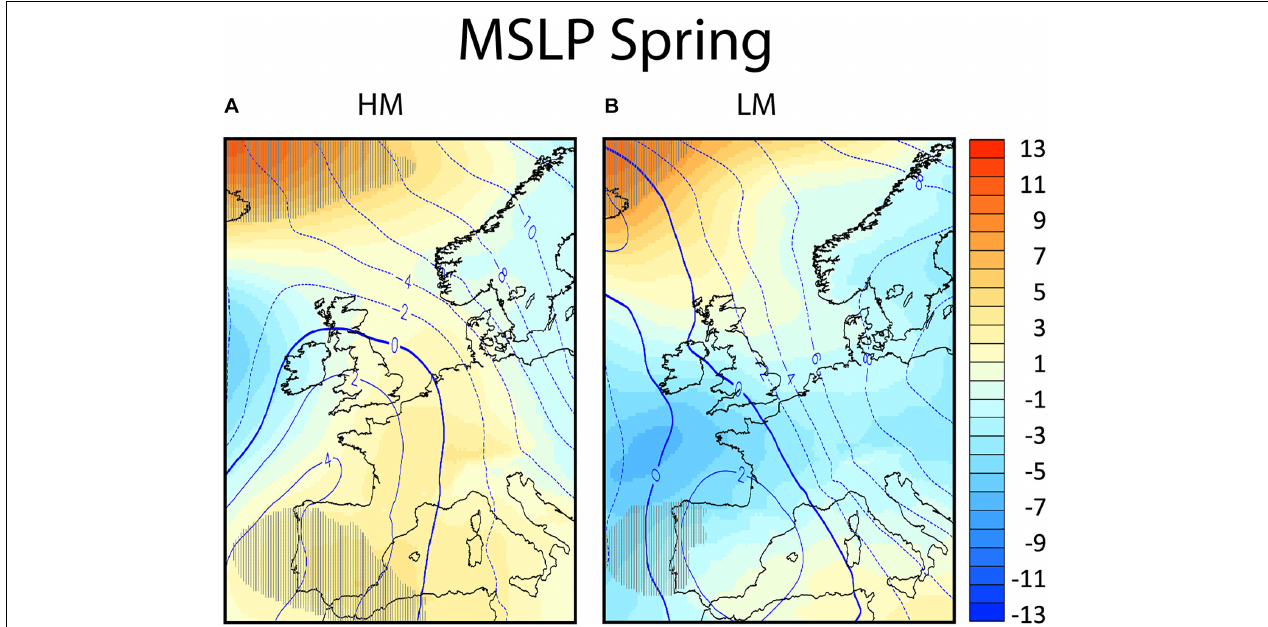
FIGURE 4 | The composites of the anomalies from climatology for spring migration for the mean sea level pressure (MLS P in hPa, in colors) and for the 500 hPa geopotential height (in decameters, in contours) in panel (A) for nights of high migration intensity (HM) and in panel (B) for nights of low migration intensity (LM). Areas exceeding the 95% confidence level as concluded by the Welch’s t -test are hatched.